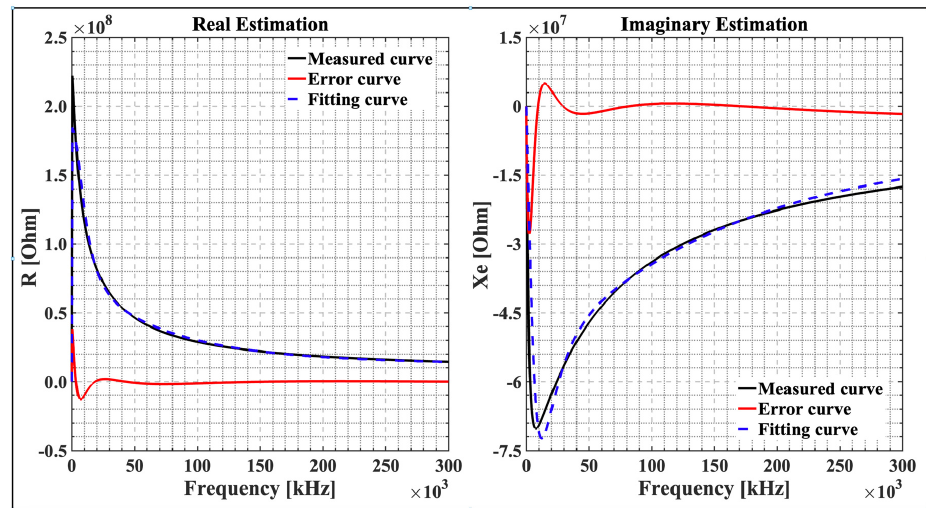
Figure 9. Experimental curve (measurement), curve fit (estimation from optimization algorithm), and error (difference between experiment and curve fit) in real and imaginary estimation graphs. The results were obtained from an optimization program in MATLAB.